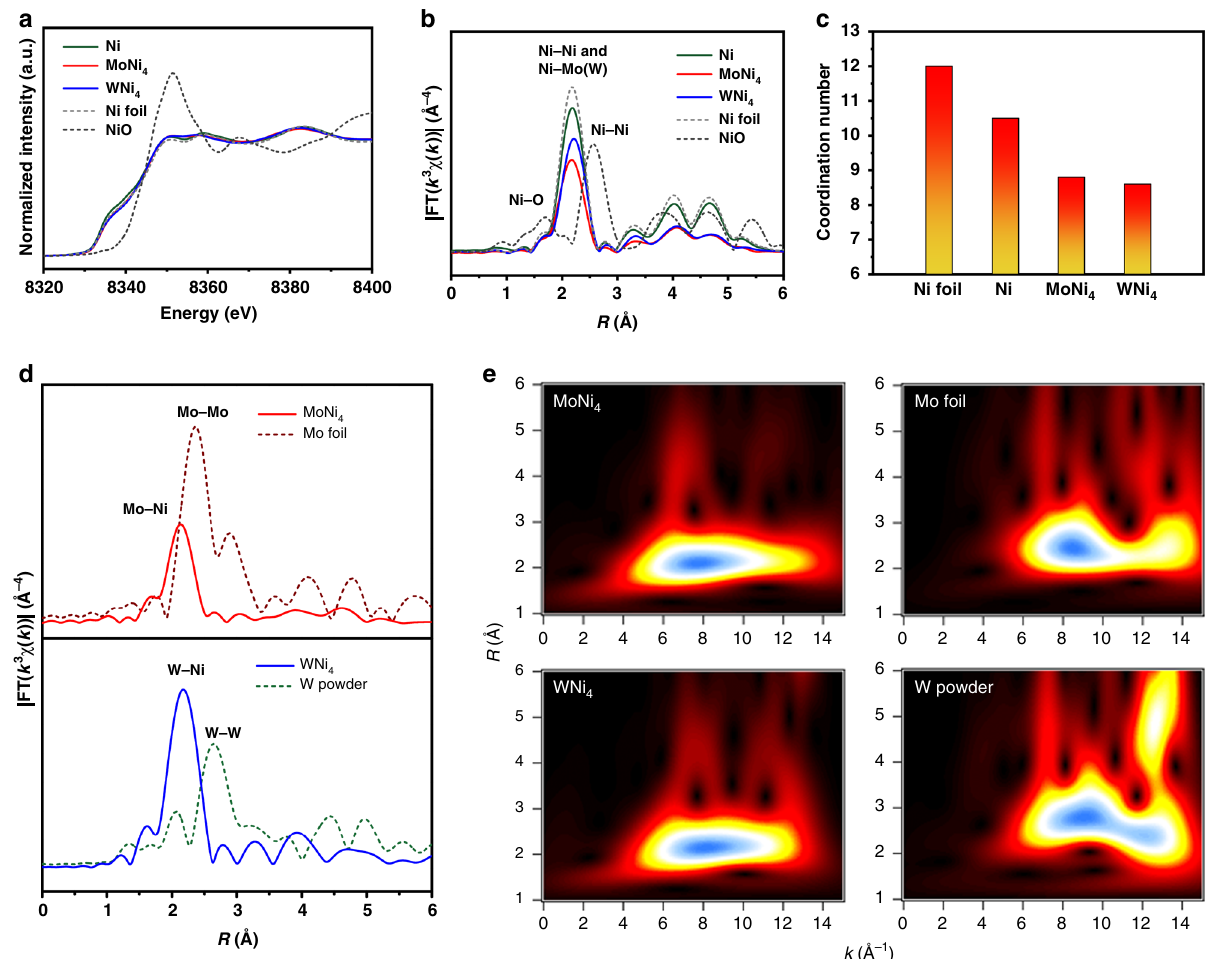
Fig. 2 Structural analyses of MoNi 4 and WNi 4 alloys. a , b Ni K-edge XANES spectra and corresponding Fourier transforms of k 3 -weighted EXAFS spectra for Mo(W)Ni 4 alloys, freshly synthesized Ni, Ni foil, and NiO reference. c The average coordination numbers (CN) in the fi rst coordination shell of Ni atoms for MoNi 4 , WNi 4 , and freshly synthesized Ni by EXAFS spectra curve fi tting. The CN of bulk Ni (Ni foil) is 12. d Fourier transforms of k 3 -weighted EXAFS spectra of Mo K-edge (up) and W L 3 -edge (down), respectively. e Corresponding wavelet transforms of k 3 -weighted EXAFS spectra of Mo K-edge (up) and W L 3 -edge (down),